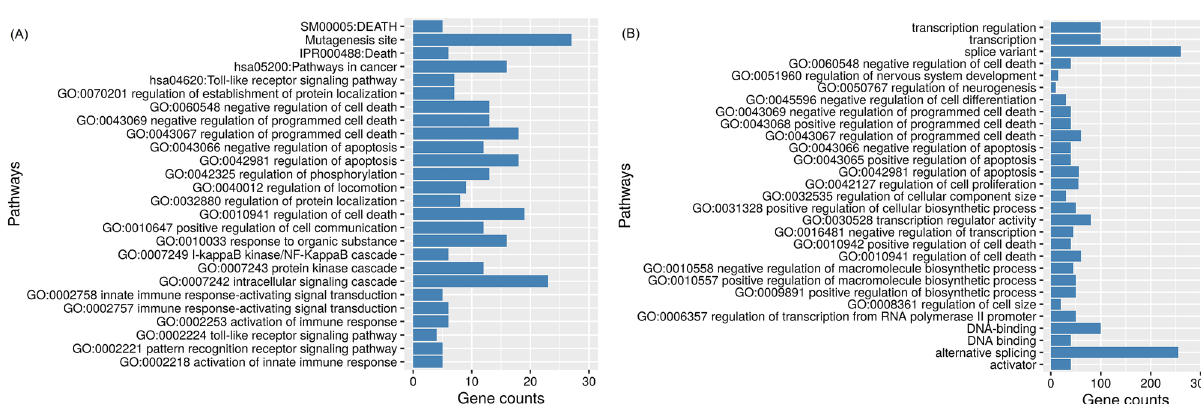
Figure 2. Enrichment analysis of upregulated ( a ) and downregulated ( b ) miRNAs target genes in DHF liver tissue using KEGG, Interpro and GO Terms obtained in DAVID Annotation Tool. All pathways have p-value adjusted by Benjamini method <